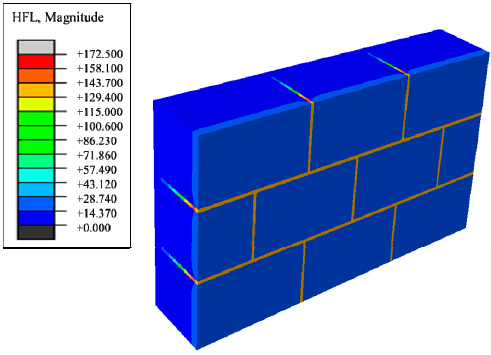
Figure 14. Transient heat transfer heat flux low peak nephogram.